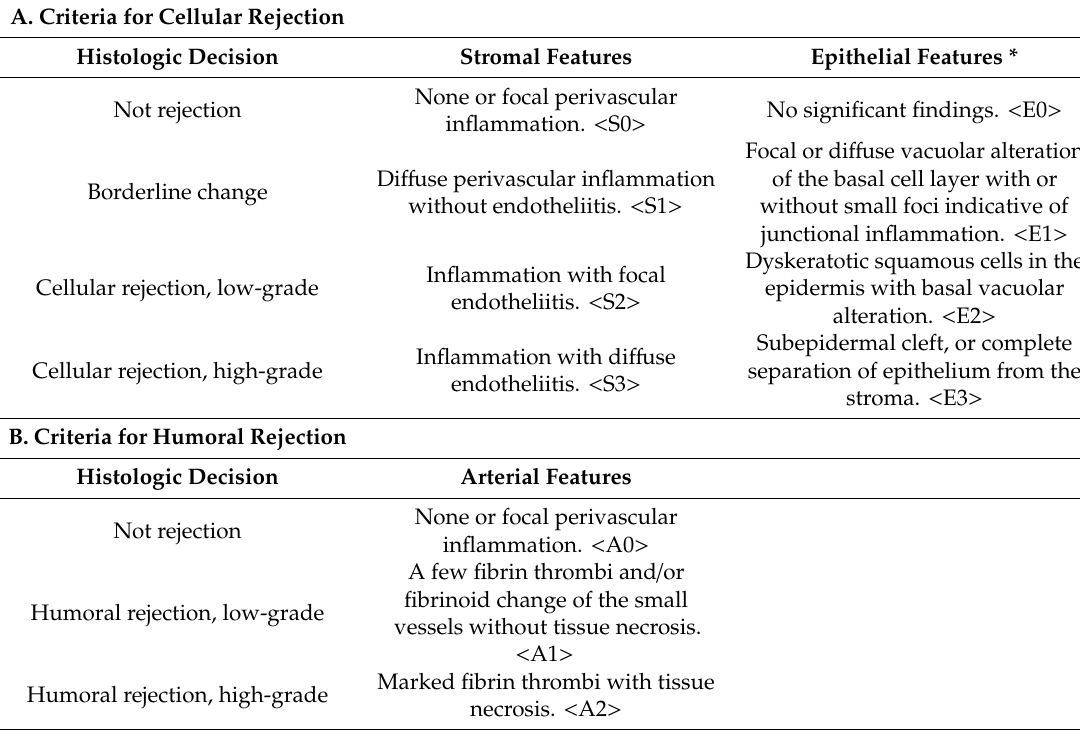
Table 4. Histologic criteria for cellular and humoral